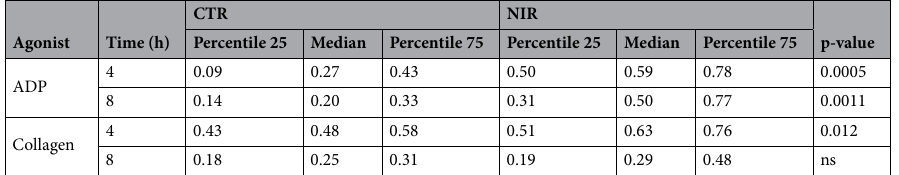
Table 3. Changes in ADP and collagen-induced PLT aggregation. Aggregation results were compared with the Wilcoxon pair test. The number of measurements n = 20.